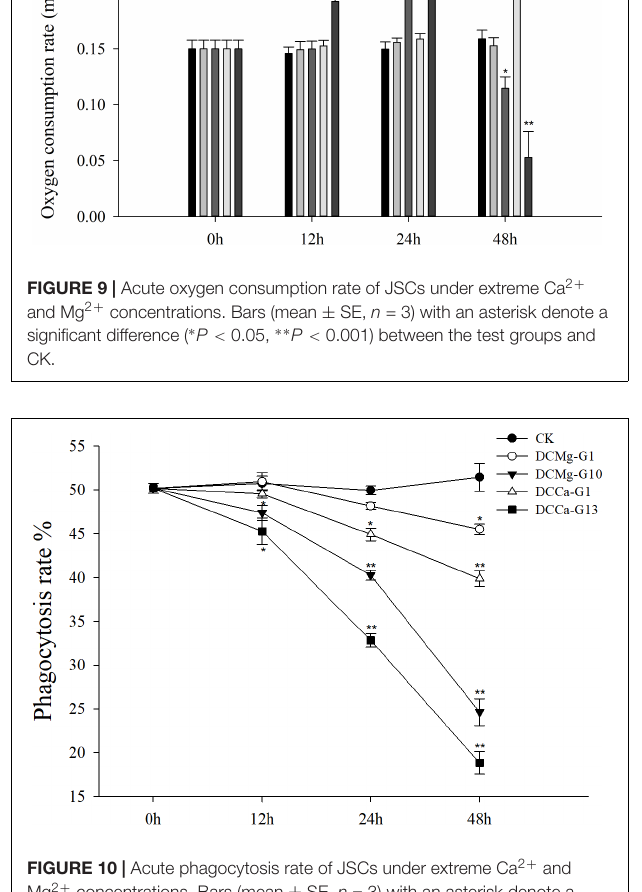
FIGURE 10 | Acute phagocytosis rate of JSCs under extreme Ca 2 + and Mg 2 + concentrations. Bars (mean ± SE, n = 3) with an asterisk denote a significant difference ( ∗ P < 0.05, ∗∗ P < 0.001) between the test groups and CK.